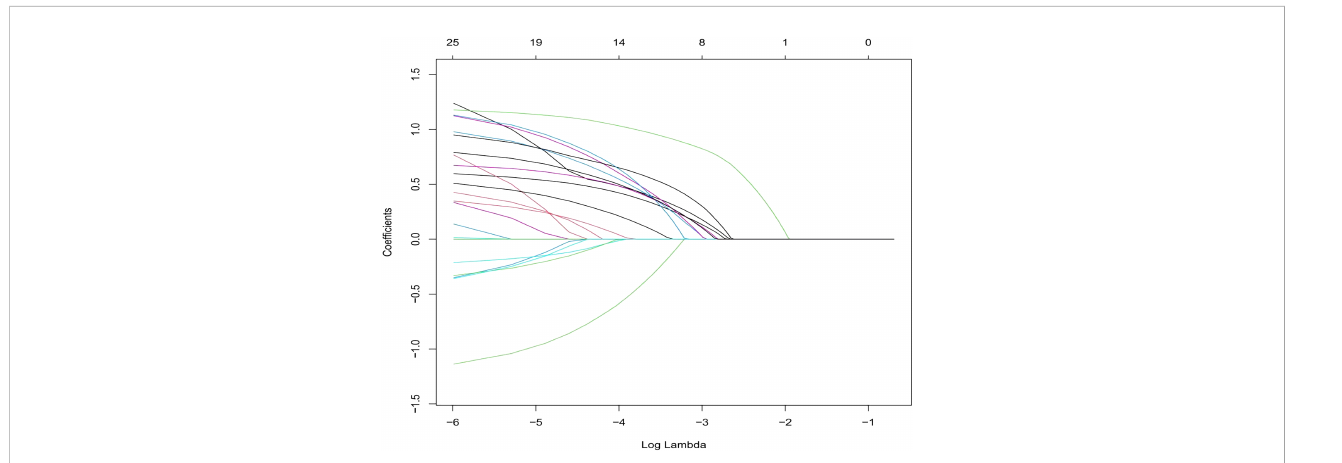
FIGURE 2 This section consists of 11 characteristics based on the sequence of the number (Lambda) sequence. A vertical line is drawn at the selected value using fi ve weights cross-veri fi cation, and the coef fi cient of fi ve elements with non-zero values is